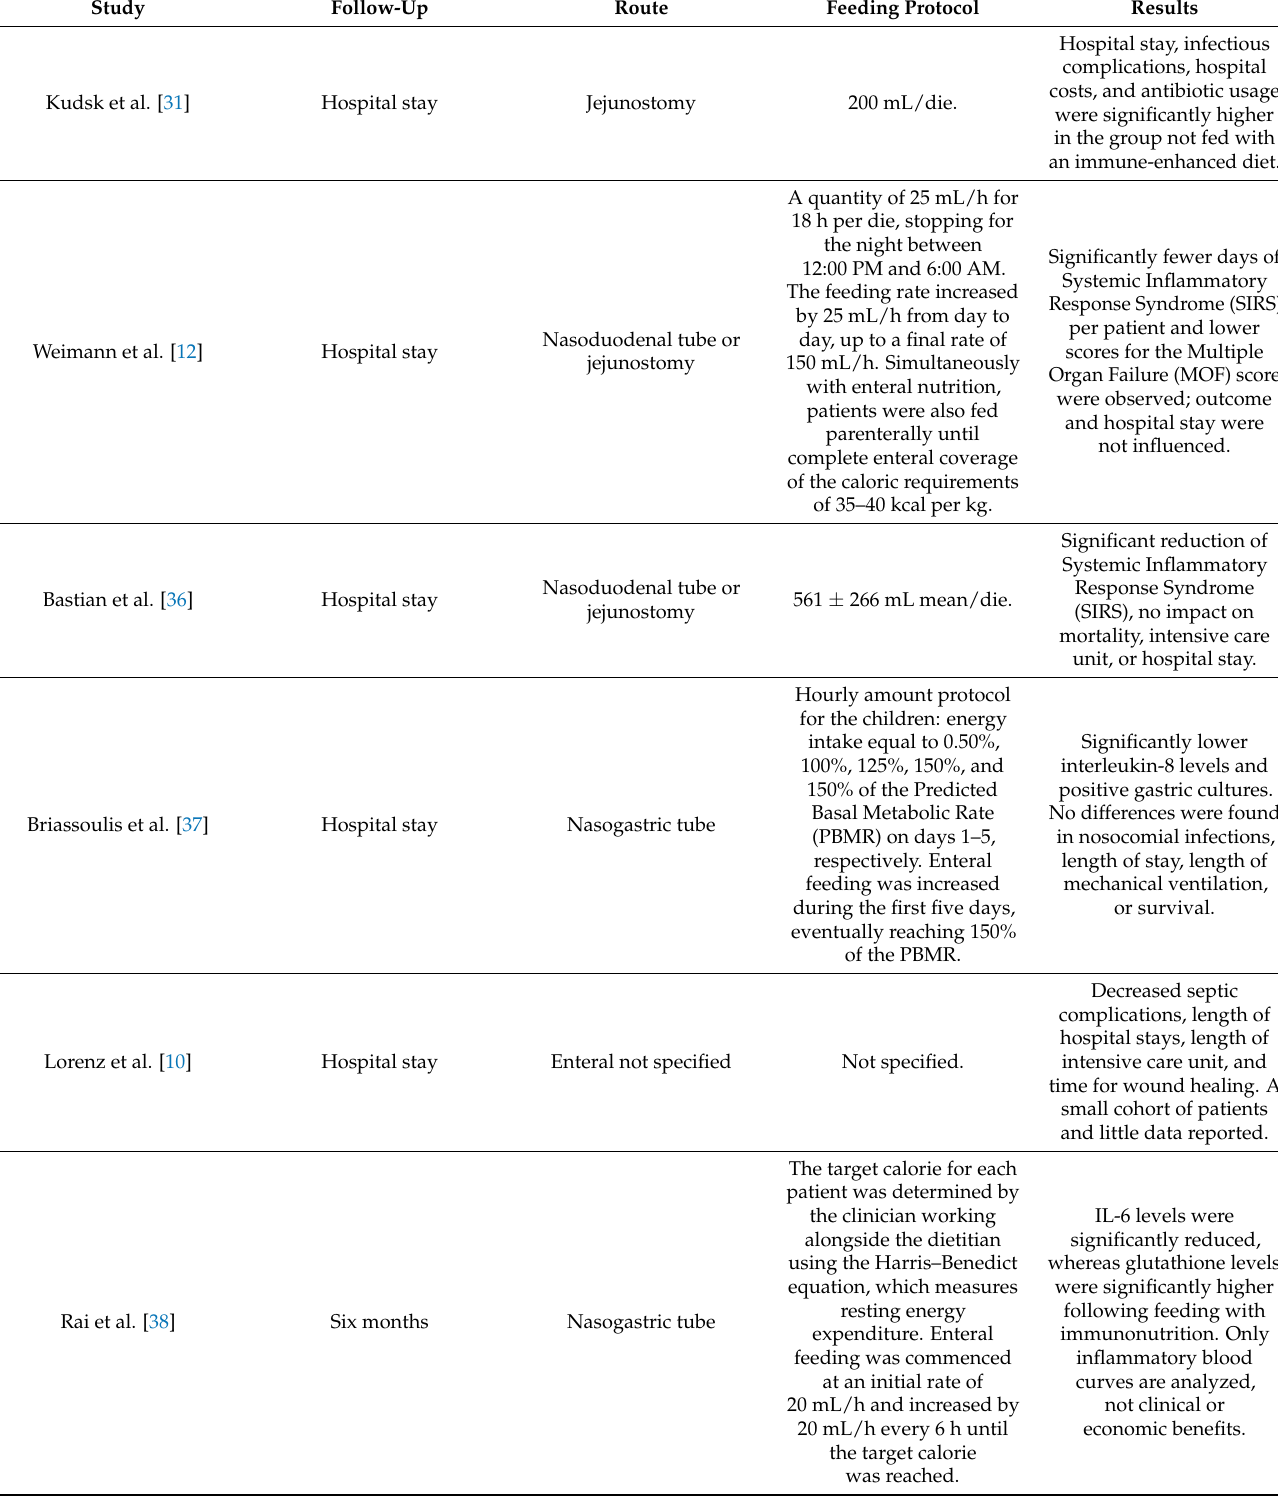
Table 2. Traumatic study rates and